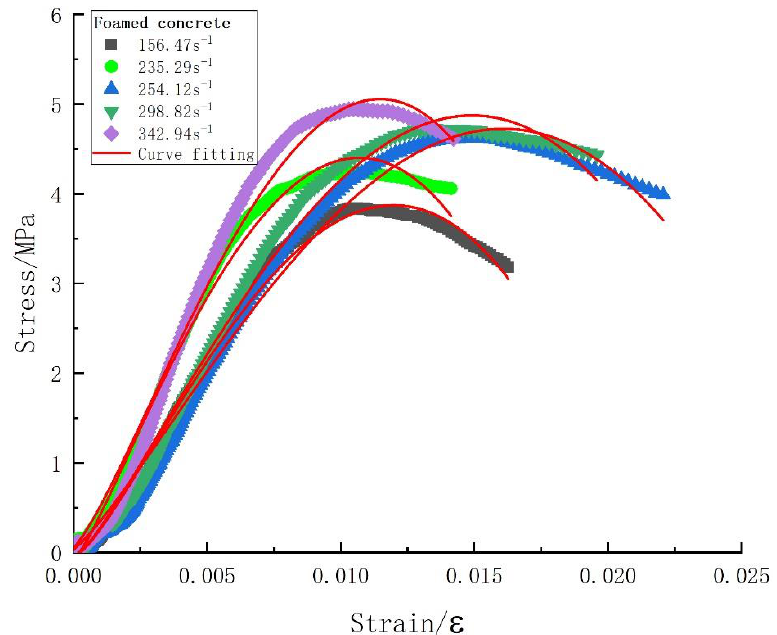
Figure 16. Foam concrete fitting curve. Table 3. Fitted curve